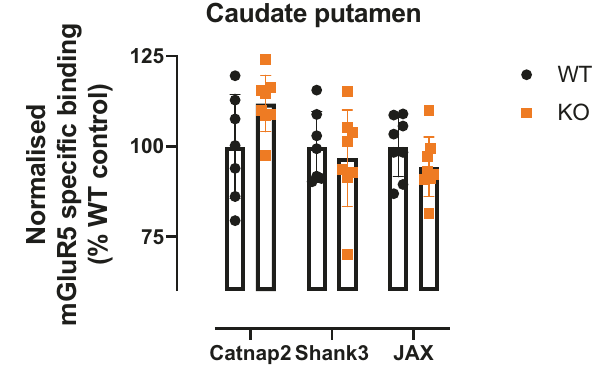
Fig. 5 Autoradiography of mGluR5 speci fi c binding in the caudate and putamen of three mouse models associated with ASD ( Cntnap2 knockout, Shank3 knockout and 16p11.2 deletion (JAX)). Wildtype littermates (WT) are represented in black and knockout (KO) mice are represented in orange. n = 7 –